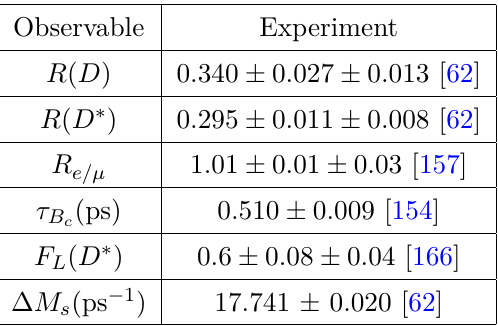
Table 2 . Observables related to the charged anomalies considered in our study. We also include the normalised distributions d Γ( B → Dτν ) / (Γ dq 2 ) and d Γ( B → D ? τν ) / (Γ dq 2 ) as measured by the BaBar collaboration